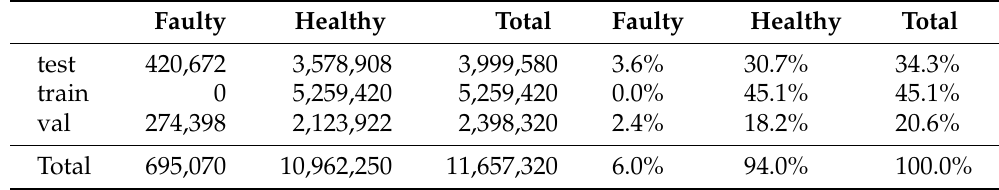
Table 5. Cooling unit dataset with 30-20 sliding